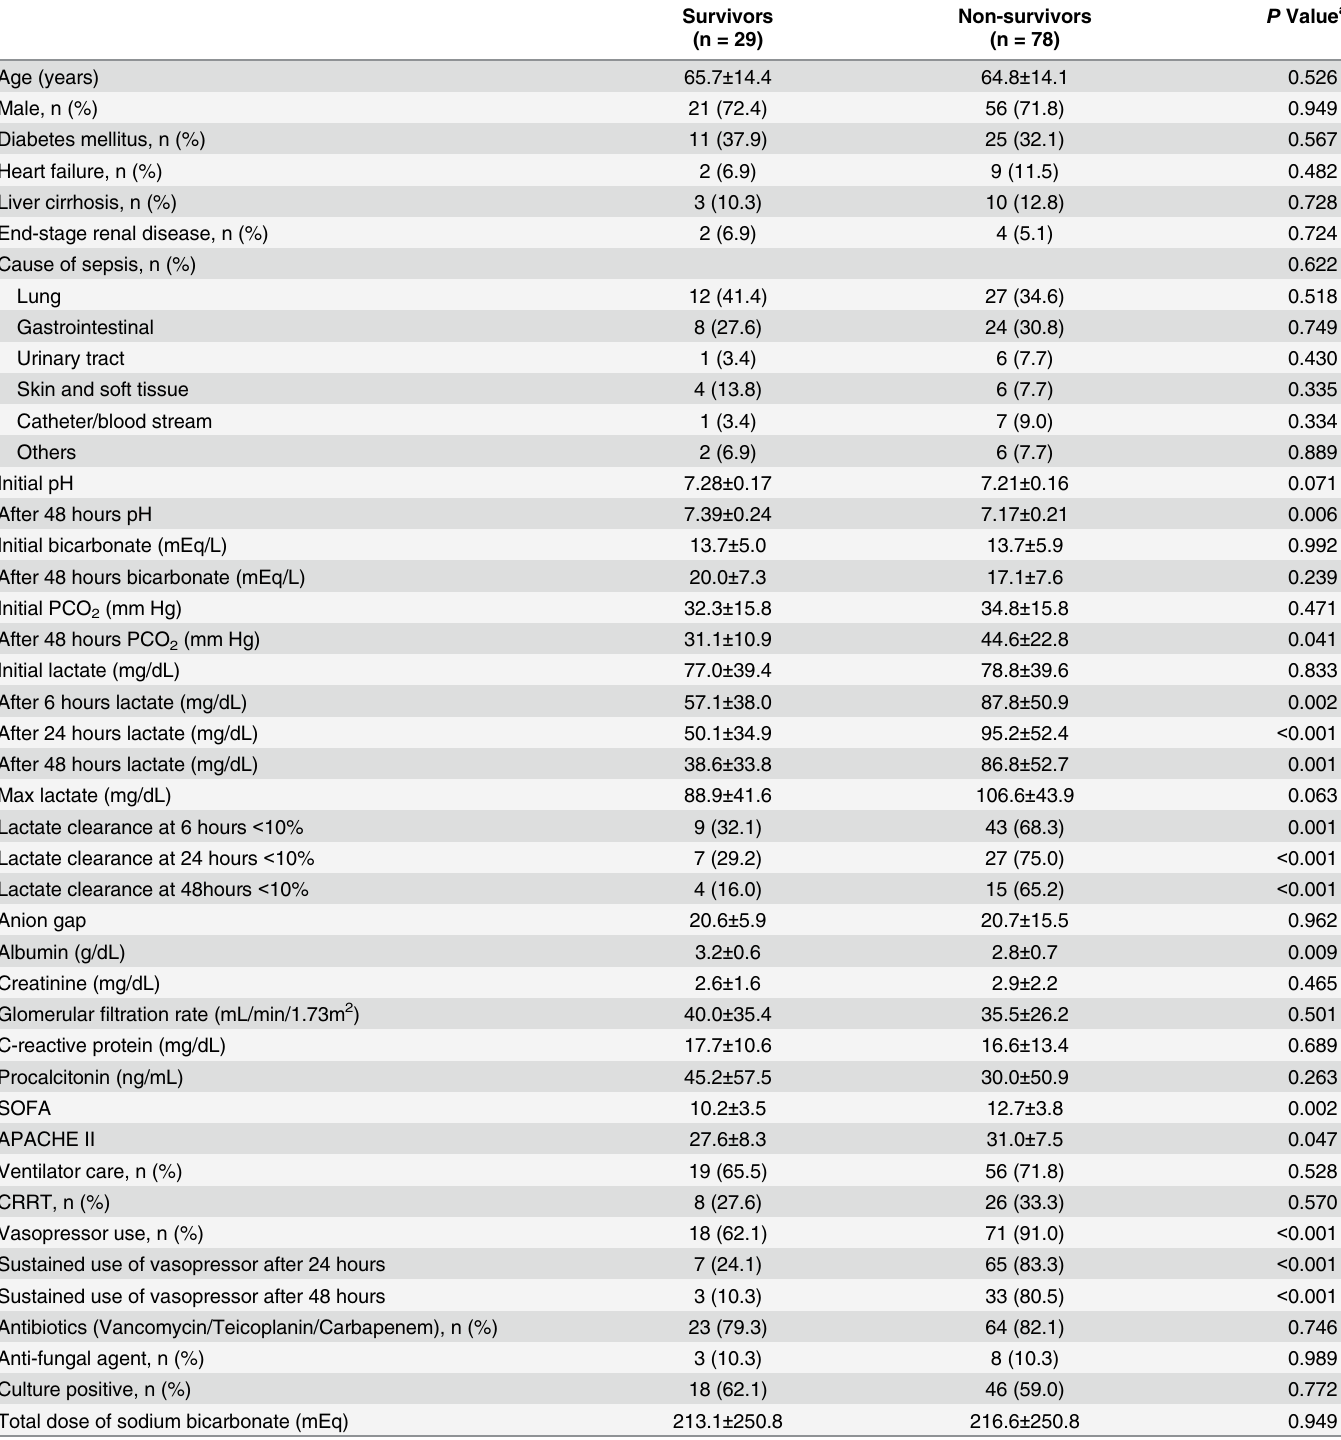
Table 2. Patient characteristics according to 7-day